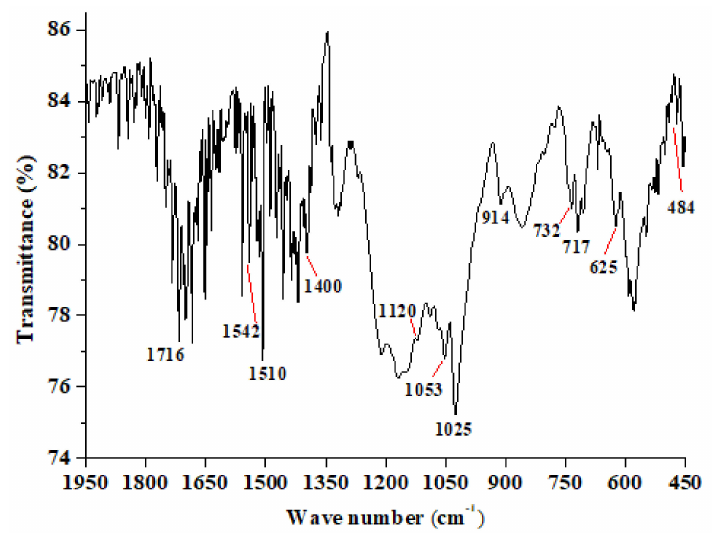
Figure 3. The FT-IR spectra of the free CoPcS catalyst (KBr tabletting treatment).